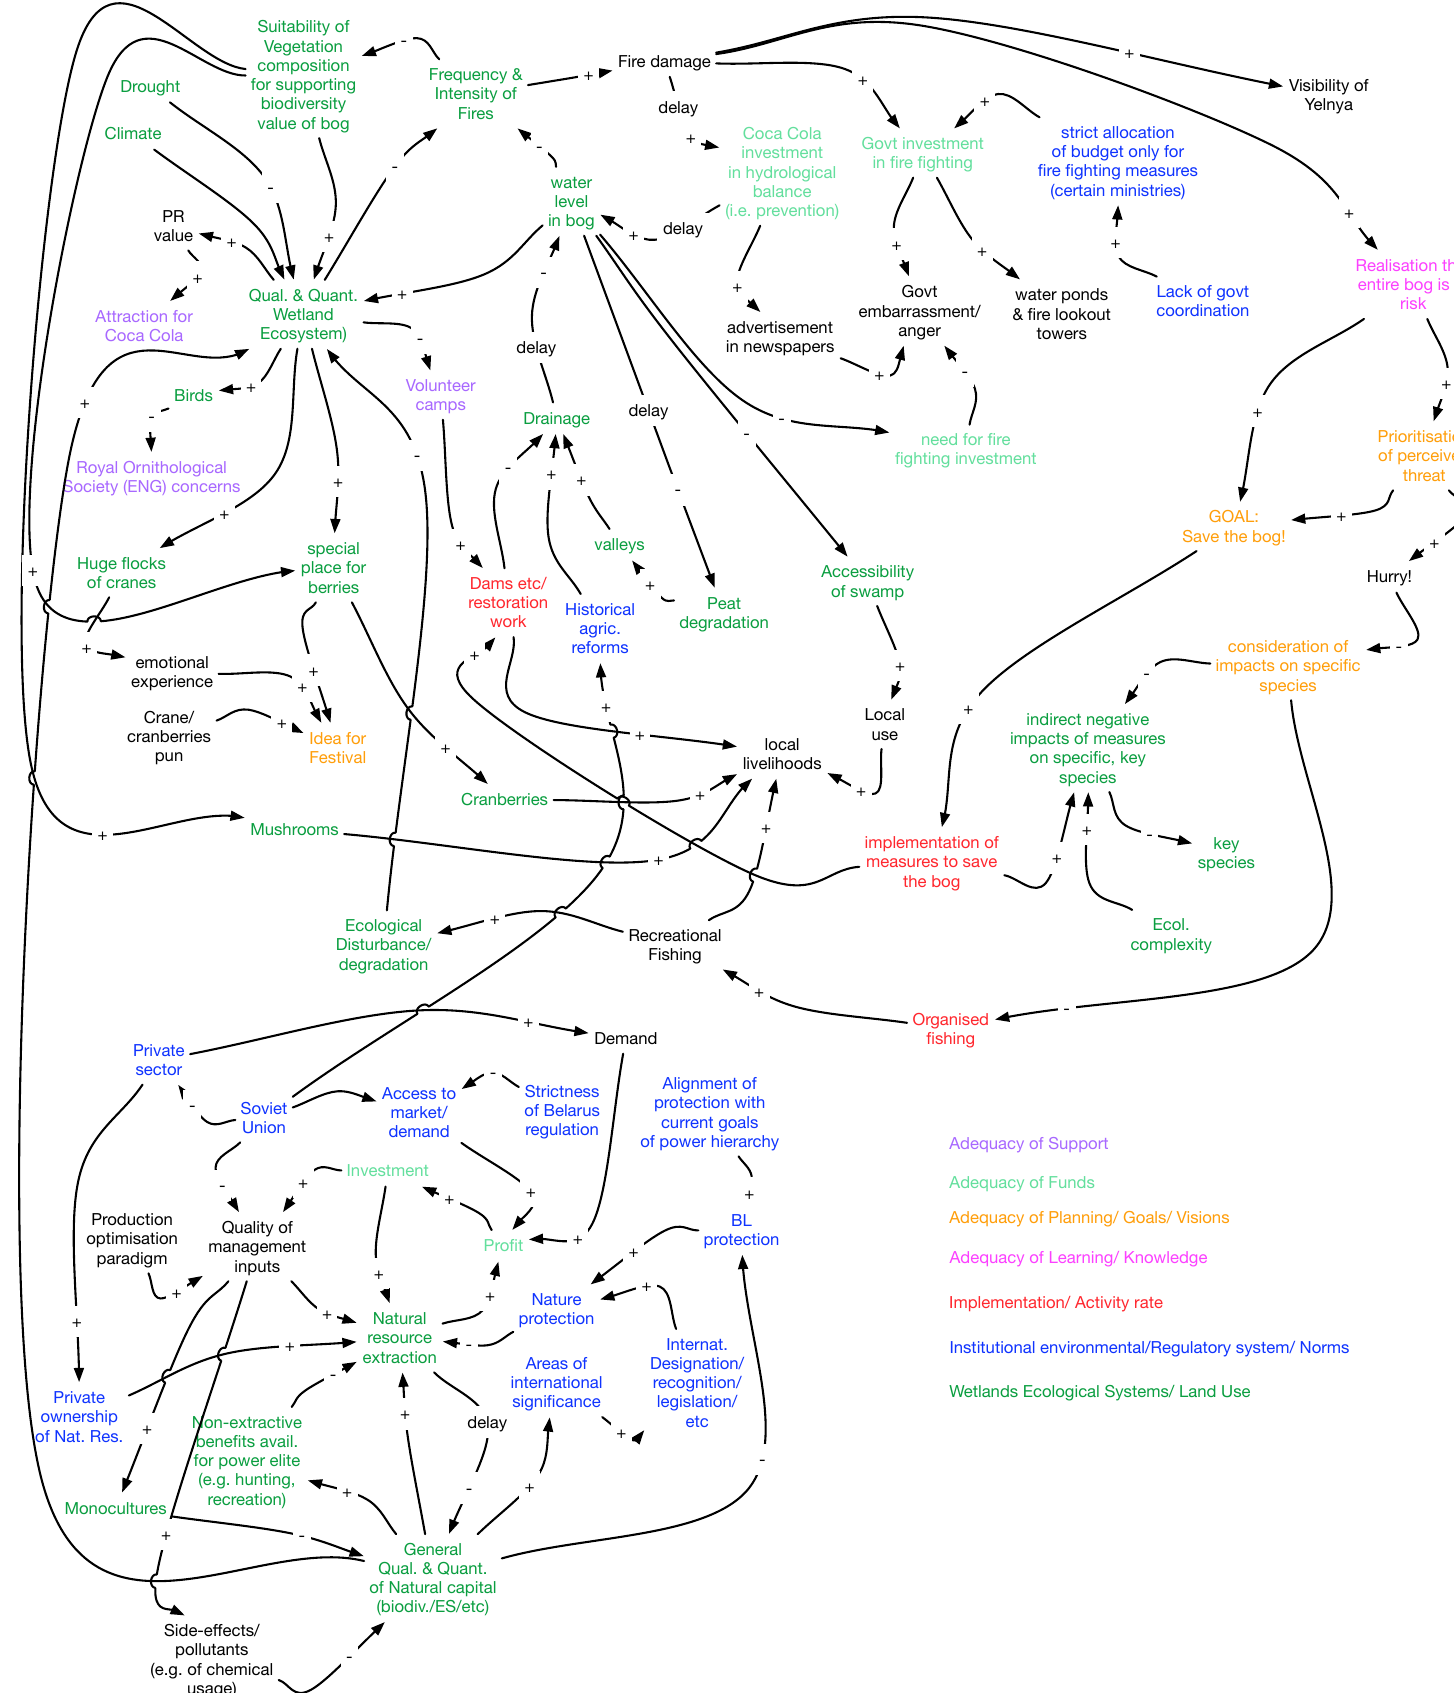
Figure A2:4. Case Bogs, Theme: Ecological system, Land